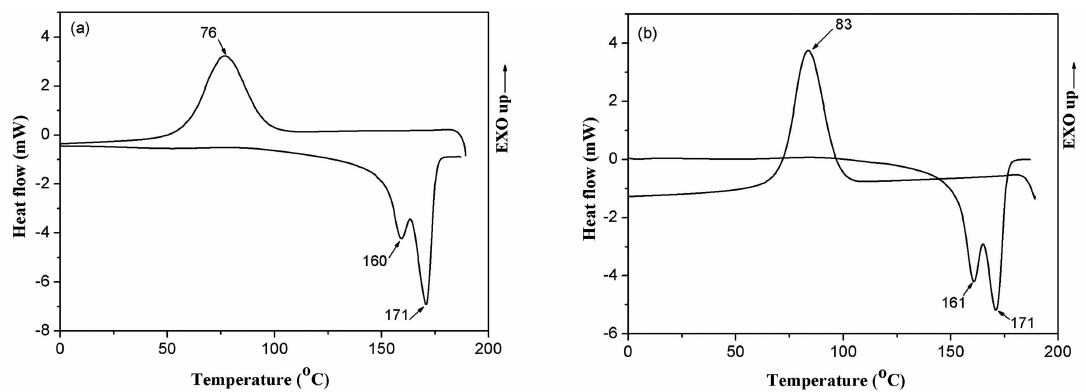
Figure 4. Cooling and second heating curves obtained by DSC of: (a) PHB thermo-compression molded film and (b) PHB electrospun nanofibers